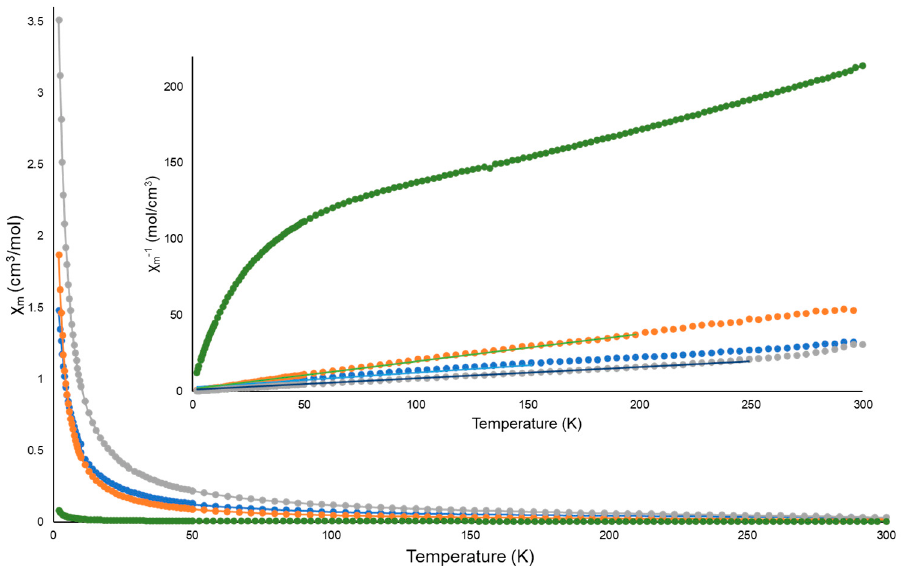
Figure 7. The χ m vT of 1 (orange) , 2 (blue), 3 (grey), and 4 (green). The insert graph depicts the χ m − 1 vT graph of 1 (orange) , 2 (blue), 3 (grey), and 4 (green) . The line of best fit for 1 (light green), 2 (light blue), and 4 (dark blue) are also shown in the insert.